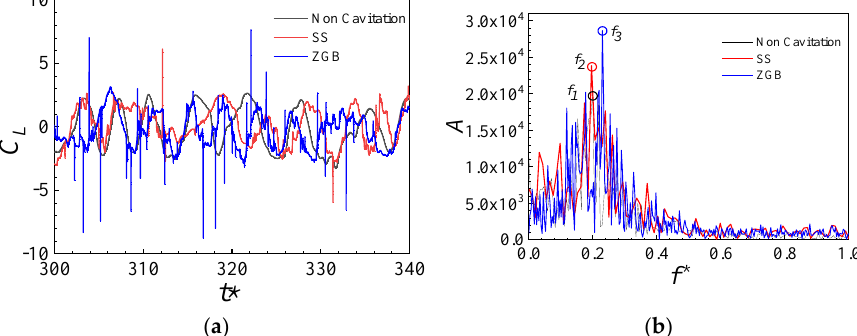
Figure 4. Lift coefficient and related amplitude spectrum for different calculation cases: ( a ) Lift coefficient; ( b ) Amplitude spectrum ( σ = 2.92).